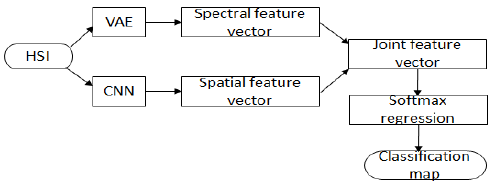
Figure 4. Flowchart for proposed